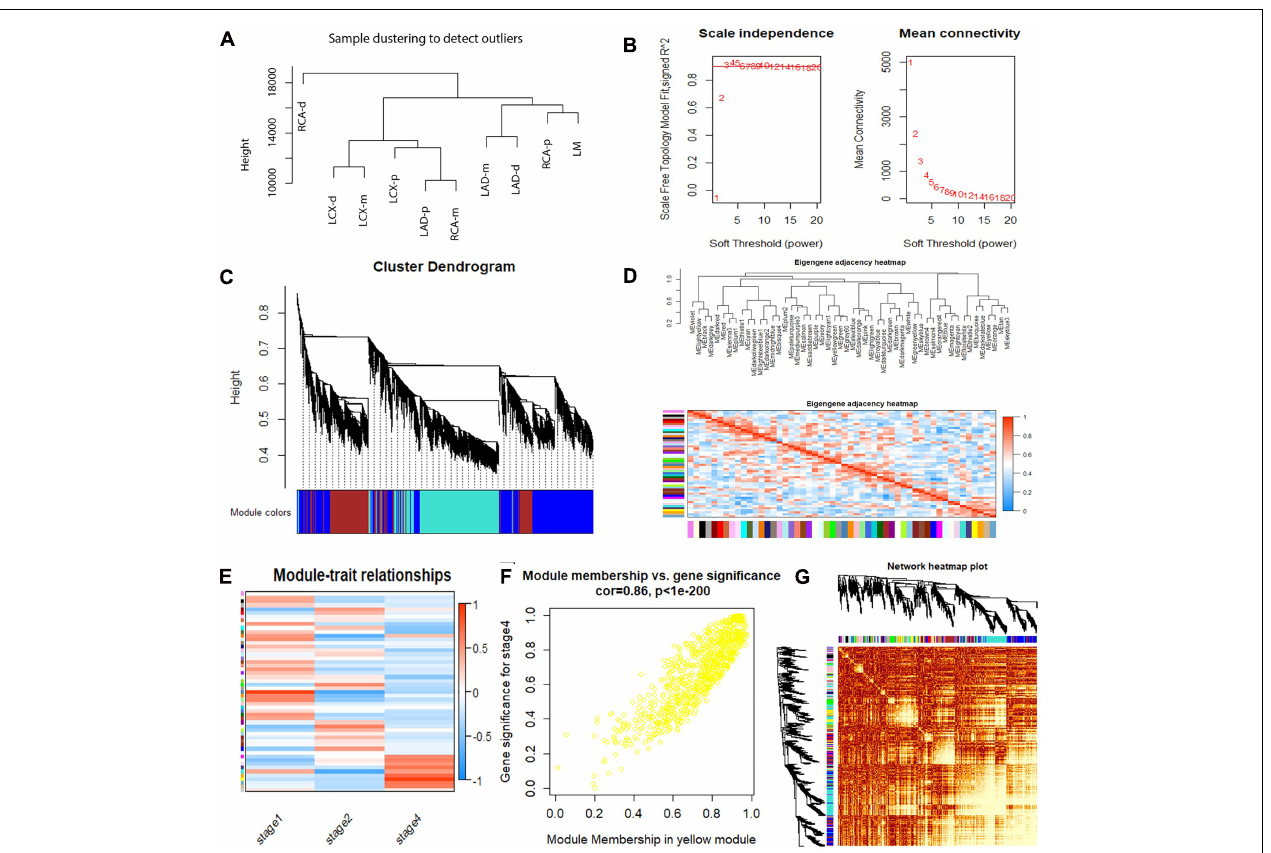
FIGURE 6 | Weighted gene coexpression network analysis (WGCNA) summary. (A) Sample clustering to detect outliers. (B) Analysis of the scale-free fit index and the mean connectivity for various soft-thresholding powers. (C) Cluster dendrogram based on the dissimilarity of the topological overlap matrix. (D) The branches of the dendrogram and the eigengene adjacency heatmap. (E) Module–trait relationship. (F) A scatterplot of gene significance (GS) vs. module membership (MM) in the yellow module. A highly significant correlation between GS and MM in the yellow module (correlation = 0.86; P value < 1 e − 200 ) was detected. (G) Network heatmap of the 53